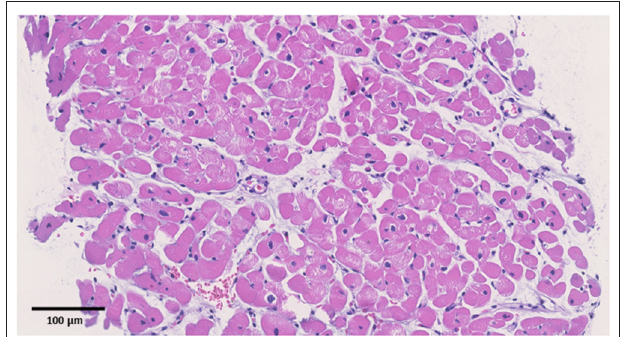
FIGURE 2 | Pathological specimens. Hematoxylin and eosin staining (original magnification × 200). The black bar indicates 100 µ m. No apparent signs of inflammation were